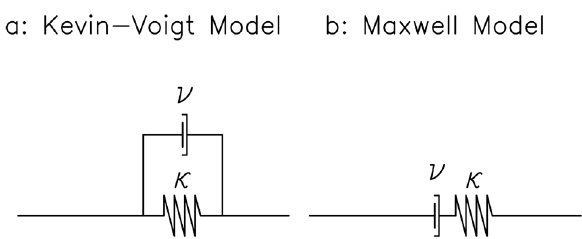
Figure 2. The two types of viscous materials: (a) for the Kelvin– Voigt model and (b) for the Maxwell model. ( l = spring constant and y = coefficient of viscosity).